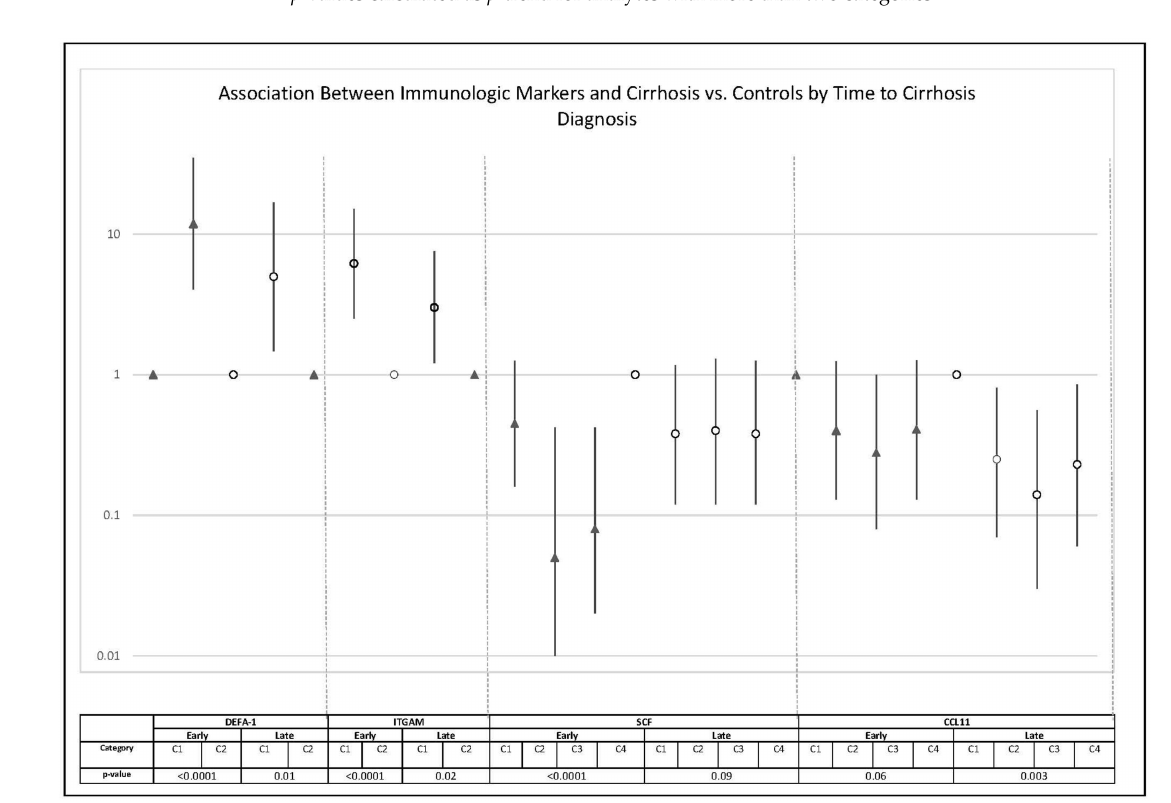
Figure 1. REVEAL-HCV odds ratios* and 95%CIs stratified by time to cirrhosis diagnosis in those who developed cirrhosis vs. controls. * Adjusted for age, sex, years of follow-up, serum alanine aminotransferase (ALT) level, alcohol, and